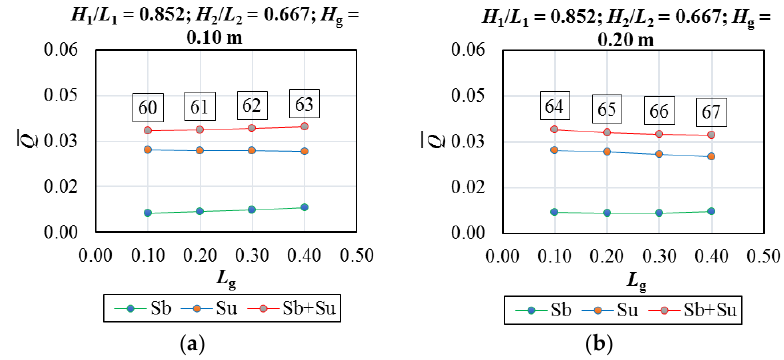
Figure 25. Behavior of Q ̅ × L g for: ( a ) cases 60, 61, 62 and 63 and ( b ) 64, 65, 66 and 67.